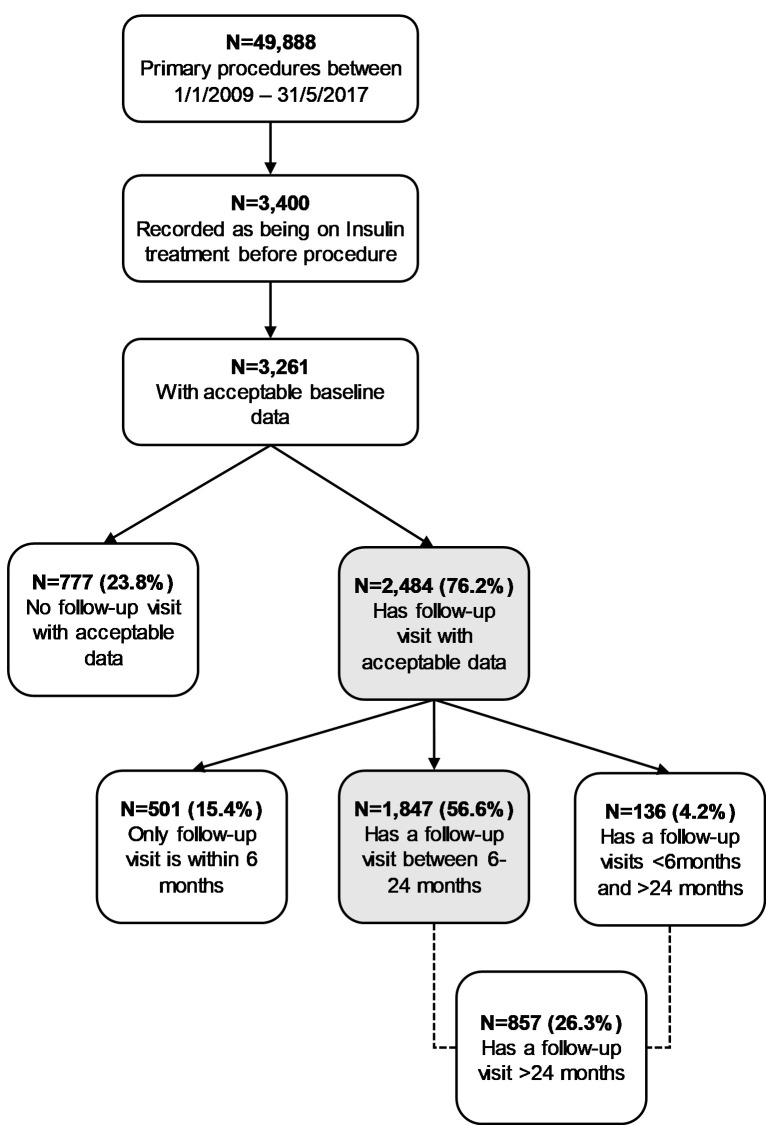
Flowchart to illustrate selection of surgical patients from NBSR database for the clinical study.NBSR, National Bariatric Surgical Registry.